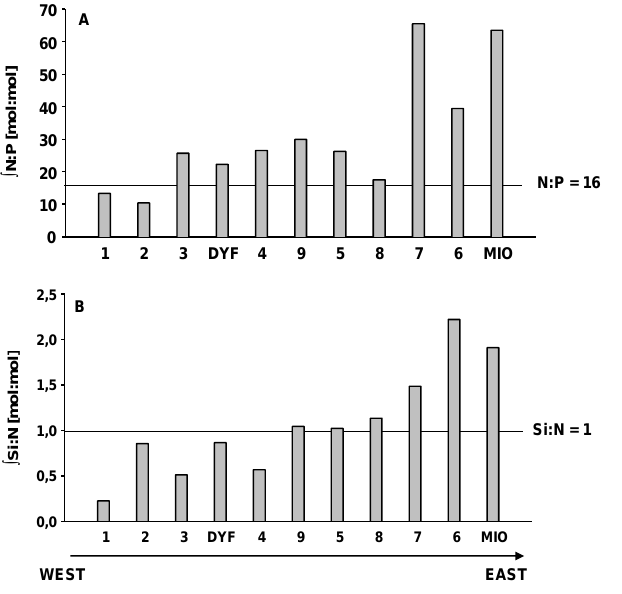
Fig. 13. Integrated N:P (A) and Si:N (B) ratios (mol:mol) over 0– 150m for the BOUM cruise along a West-East gradient. Integration made under 150m is signified by a red star. Integration was made over 118m for station 17 and 100m for station